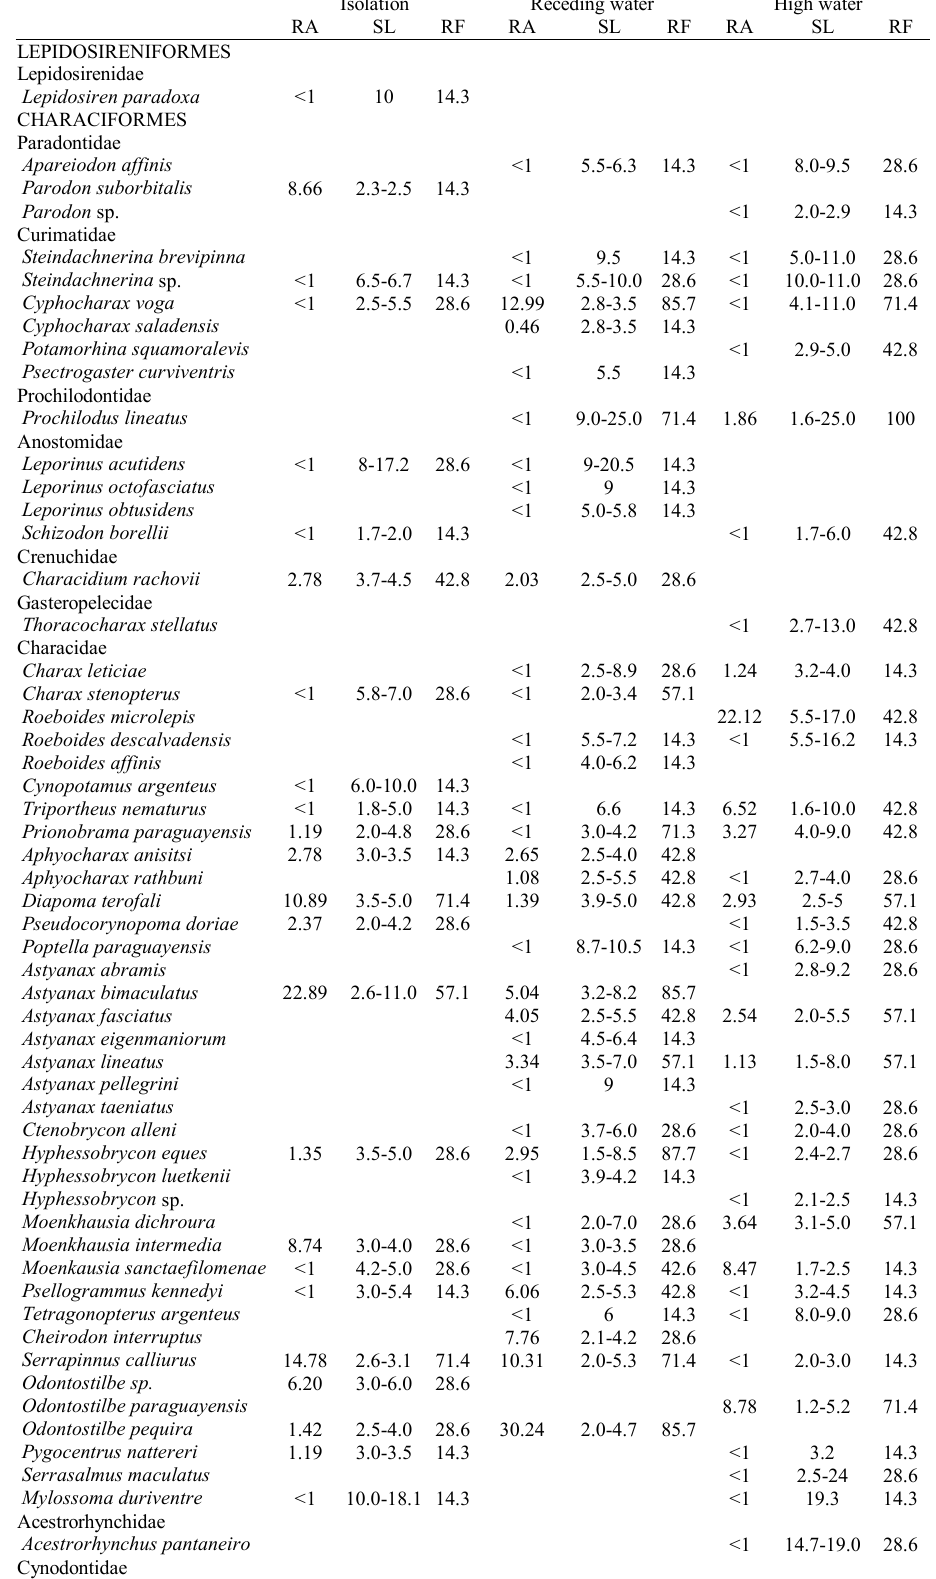
Table 2. Relative abundance of the total number of individuals represented by each species (RA), range of standard length (SL, cm) and relative frequency which each was collected (RF) in different hydrological